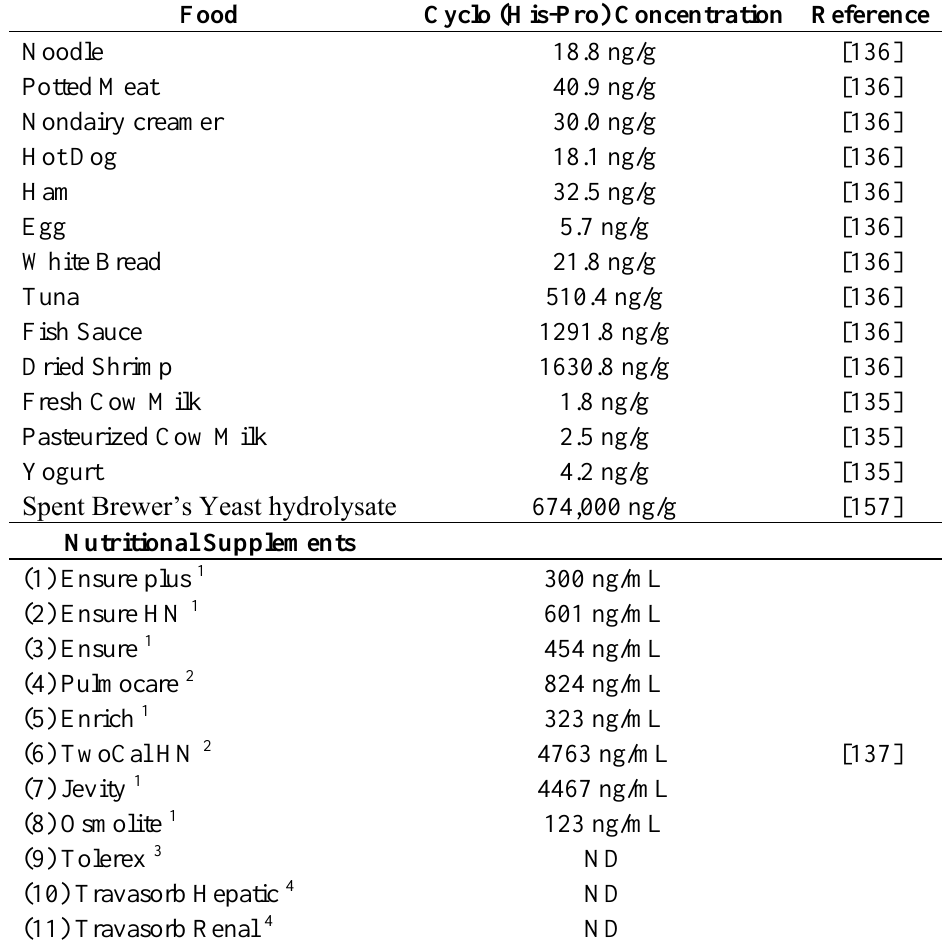
Table 2. Presence of cyclo (His-Pro) in some common foods. Nutritional supplements were products of Ross Laboratories, Columbus, OH (1–8), Norwich Eaton, Norwich, New Your (9), and Travenol Laboratories, Deerfield, IL (10 and 11). Protein source: 1 Casein + Soy, 2 Casein, 3 Essential amino acids, 4 Crystalline amino acids. ND = Not detected. Food Cyclo (His-Pro) Concentration Reference Noodle 18.8 ng/g [136] Potted Meat 40.9 ng/g [136] Nondairy creamer 30.0 ng/g [136] Hot Dog 18.1 ng/g [136] Ham 32.5 ng/g Egg 5.7 ng/g White Bread 21.8 ng/g Tuna 510.4 ng/g Fish Sauce 1291.8 ng/g Dried Shrimp 1630.8 ng/g Fresh Cow Milk 1.8 ng/g Pasteurized Cow Milk 2.5 ng/g Yogurt 4.2 ng/g Spent Brewer’s Yeast hydrolysate 674,000 ng/g Nutritional